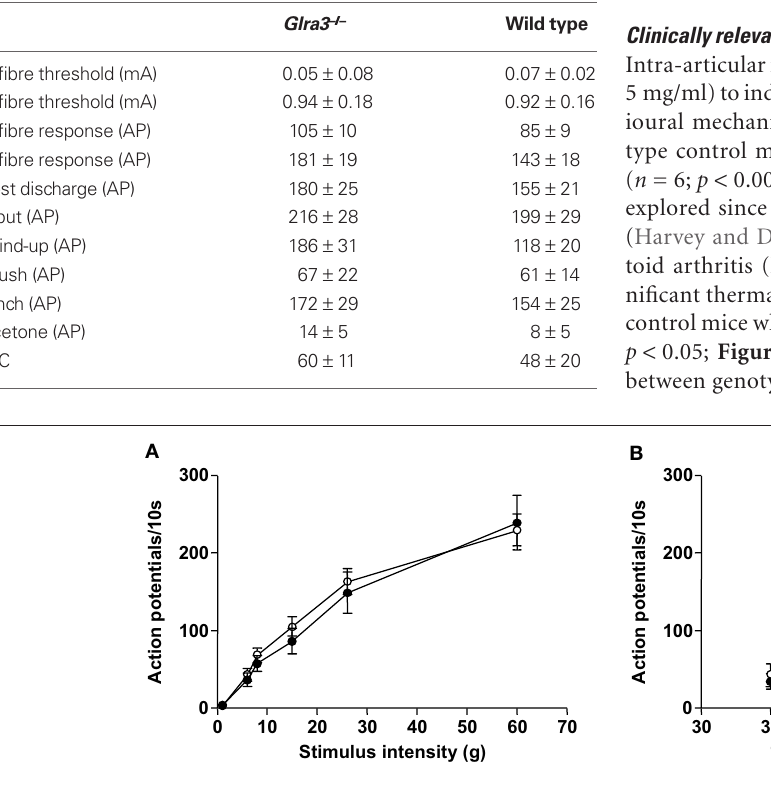
FIGURE 2 | Glra3 − / − mice show no differences in evoked dorsal horn neuronal responses. (A) Graded mechanical stimuli (von Frey); (B) graded thermal stimuli (water jet). Data are presented as mean ± SEM ( Glra3 − / − , n = 27; wild type, n = 22).